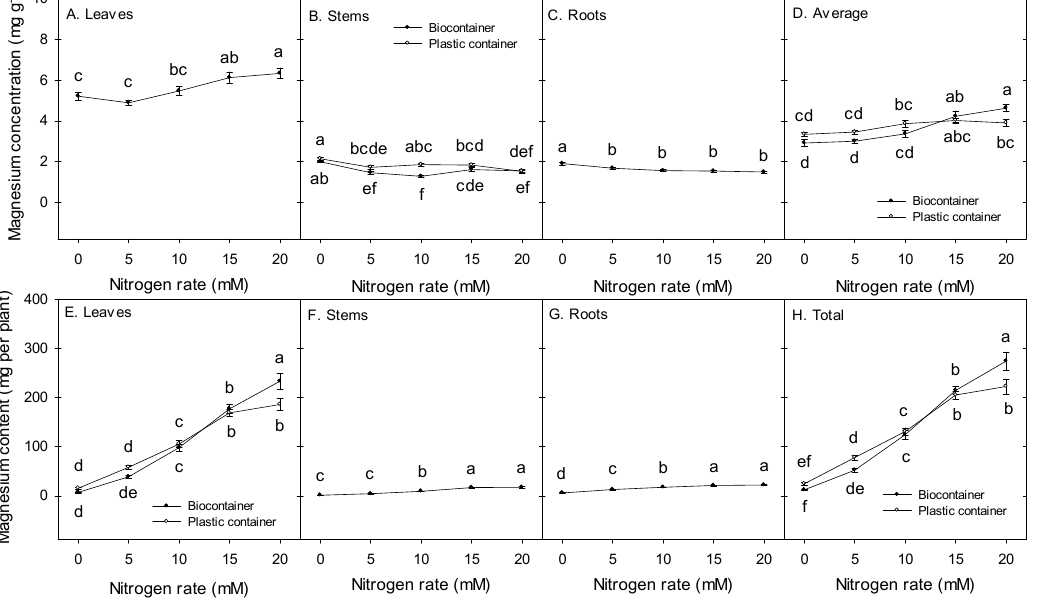
Figure 3. Concentrations (mg g − 1 ) and contents (mg per plant) of Magnesium (Mg) in leaves, stems, roots, or the entire plant of H. macrophylla ‘Merritt’s Supreme’ a ff ected by the interaction between nitrogen (N) rate and container type ( B , D , E , H ) or by the main e ff ect of N rate ( A , C , F , G ). Data points are means ( B , D , E , H ) across irrigation frequencies ( n = 10) and ( A , C , F , G ) across container types and irrigation frequencies ( n = 20). Error bars are standard errors. Di ff erent lower-case letters within a chart indicate significance di ff erences between means using Tukey’s HSD test at p -value ≤ 0.05. Concentration of Mg in leaves and roots were a ff ected by the main e ff ect of N rate.